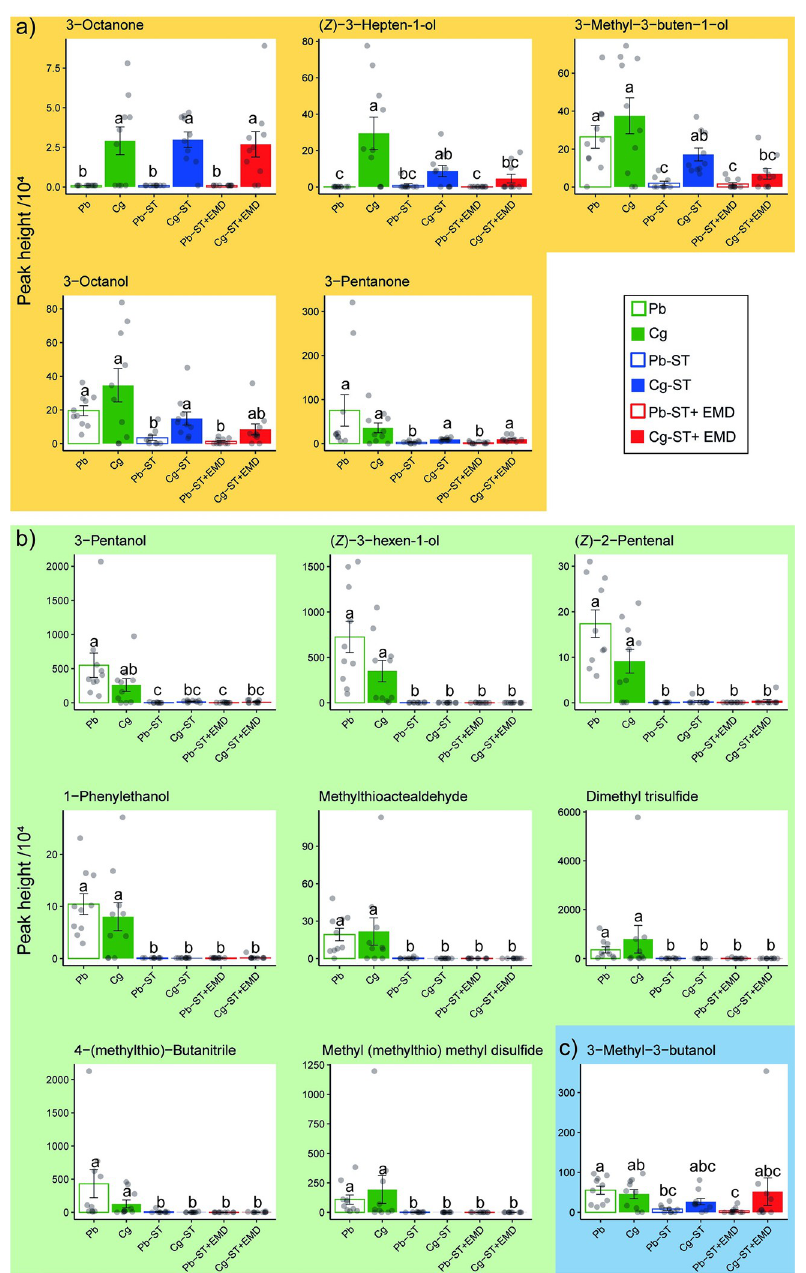
Fig 2. Volatile compounds (tentative identification) detected in the headspace of untreated, starved or starved then external microbiome disrupted unparasitised or C . glomerata parasitised caterpillars ( P . brassicae ) with a Variable Importance in the Projection (VIP) values > 1 for the OPLS-DA. Amounts of individual compounds are given as the average of peak height /10 4 ( ± SE). Statistical differences among treatments for compounds with VIP score > 1 are indicated with different letters based on Kruskal-Wallis tests with Dunn’s test for multiple comparisons including a Bonferroni correction. a) Compounds in yellow background are correlated with parasitism status. b) Compounds in green background are correlated with the presence/absence of frass. c) Compound in blue background is not correlated to either of these. Abbreviations used: Pb = Untreated unparasitised caterpillars; Cg = Untreated parasitised caterpillars; Pb-ST = starved unparasitised caterpillars; Cg-ST = starved parasitised caterpillars; Pb-ST +EMD = starved then external microbiome disrupted unparasitised caterpillars. Cg-ST+EMD = starved then external microbiome disrupted parasitised